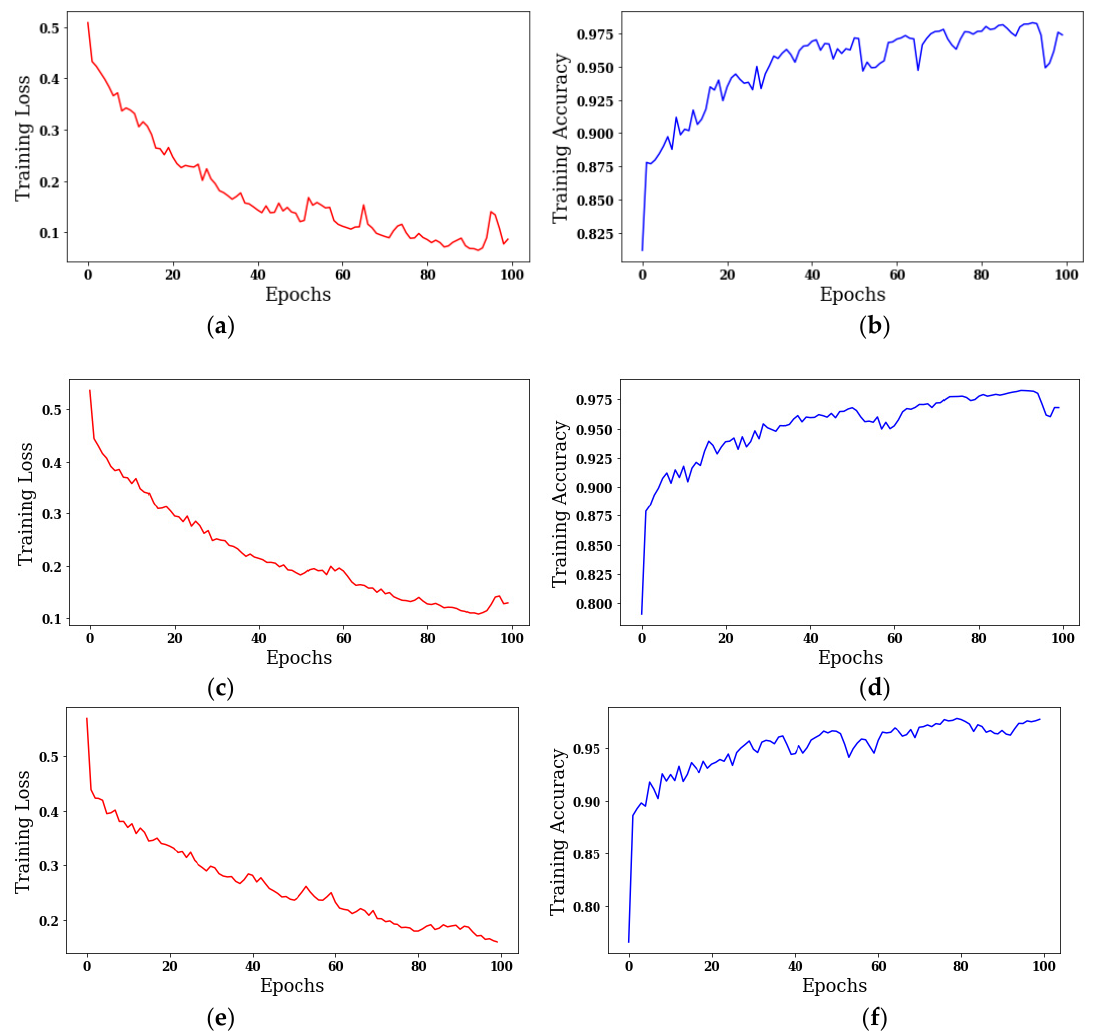
Figure 8. Analysis of training loss and training accuracy: ( a ) Training Loss on batch size 8; ( b ) Training Accuracy on batch size 8; ( c ) Training Loss on batch size 18; ( d ) Training Accuracy on batch size 18; ( e ) Training Loss on batch size 32; ( f ) Training Accuracy on batch size 32.